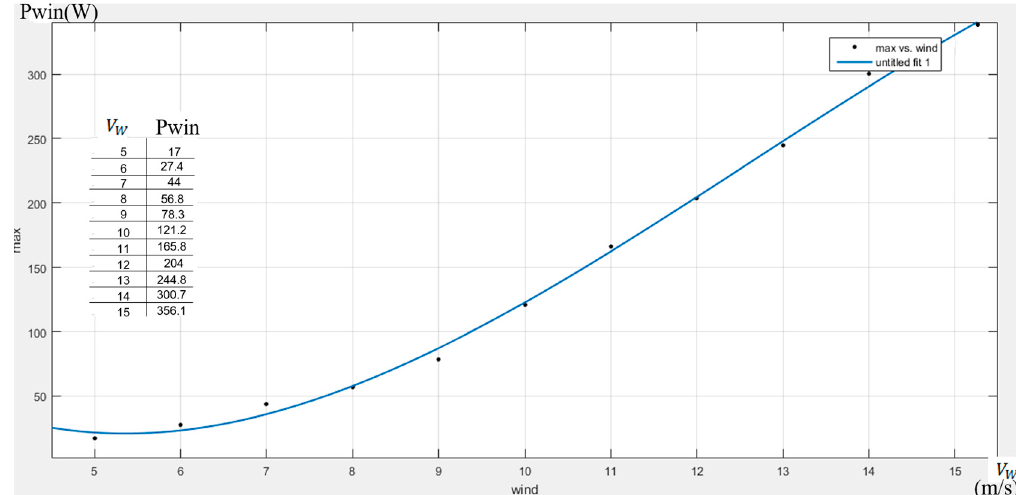
Figure 12. The fitting curve of the maximum output power of PMSG.